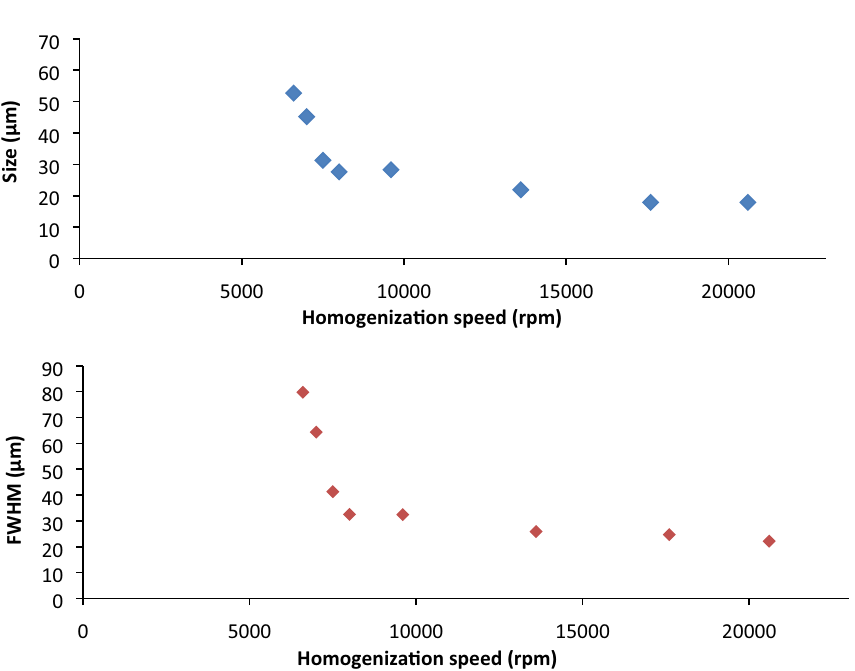
PLGA microparticles.